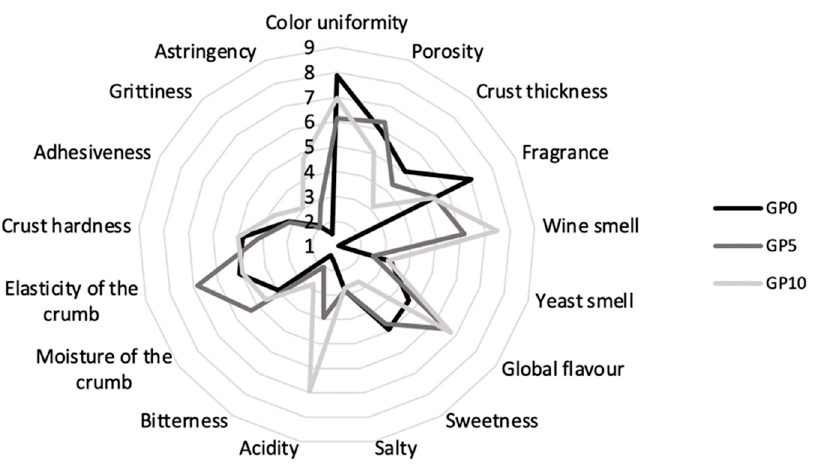
Figure 2. Sensory profile of quality attributes of bread fortified with different grape pomace levels (GP0 black line; GP5 gray line; GP10 light gray line). Sensory attributes were evaluated using a hedonic 9-point scale, where 1 and 9 indicate the lowest and the highest intensity, respectively.